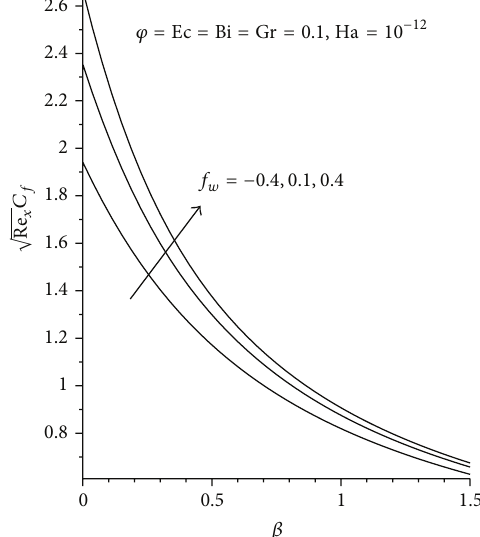
f w = −0.4,0.1, 0.4